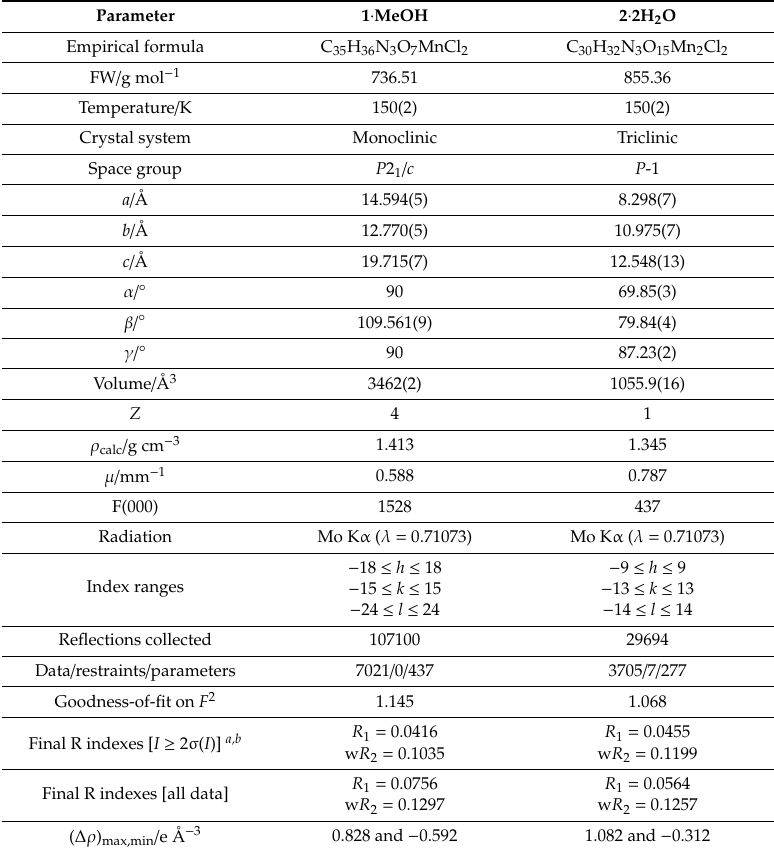
Table 1. Crystallographic data for complexes 1 · MeOH and 2 · 2H 2